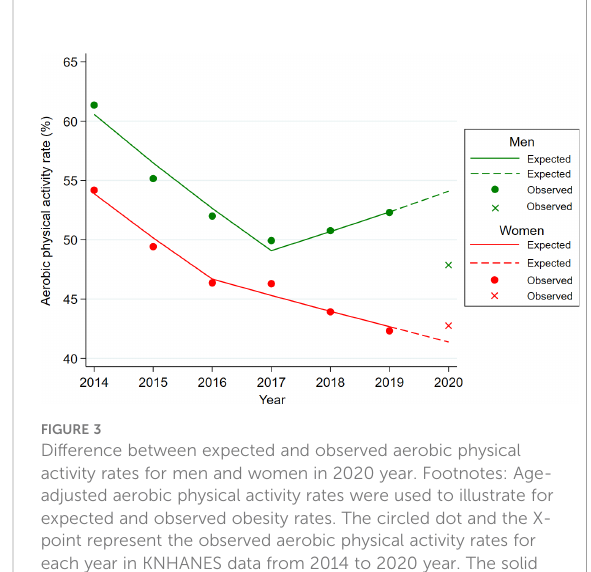
FIGURE 3 Difference between expected and observed aerobic physical activity rates for men and women in 2020 year. Footnotes: Age- adjusted aerobic physical activity rates were used to illustrate for expected and observed obesity rates. The circled dot and the X- point represent the observed aerobic physical activity rates for each year in KNHANES data from 2014 to 2020 year. The solid represent the expected aerobic physical activity rates fi tted by the Joinpoint regression model using the KNHANES data from 2014 to 2019 year. The dashed line is the predicted value of the year